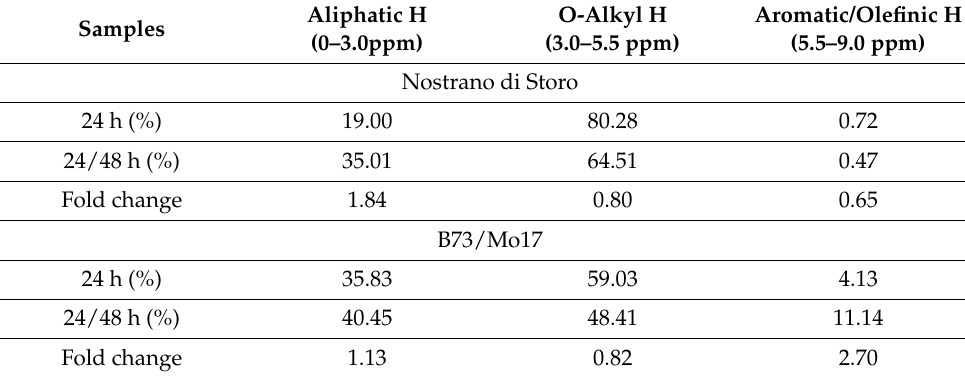
Table 2. Relative proportion (%) of the components obtained by 1 H NMR analysis and relative fold change in the analyzed time